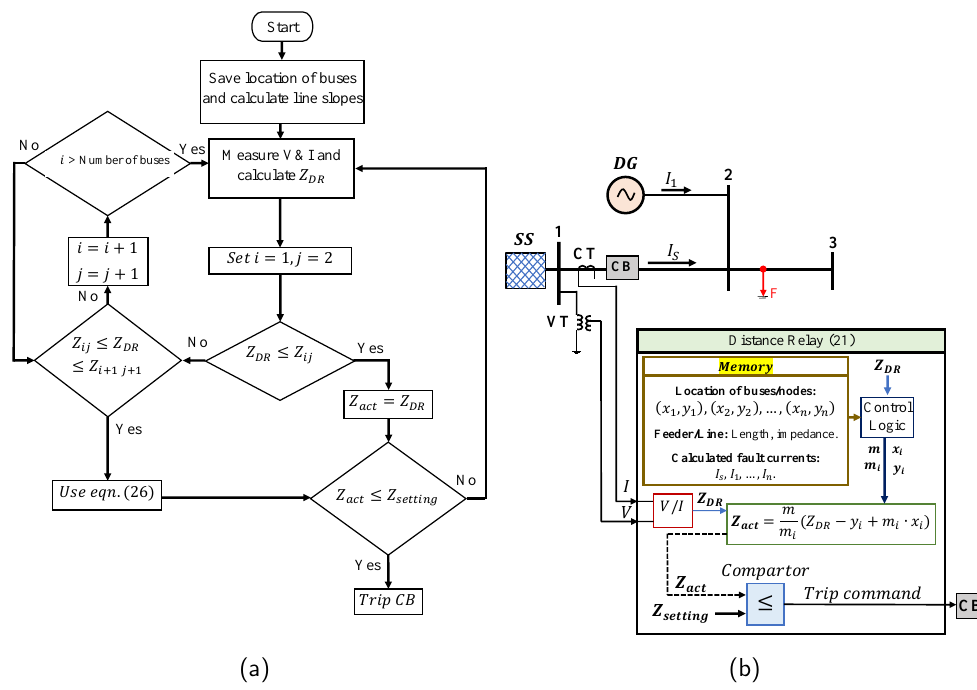
Figure 10. Method 1 for calculating the feeder impedance in presence of infeed effect: ( a ) flowchart of Method 1; ( b ) simplified schematic diagram of Method